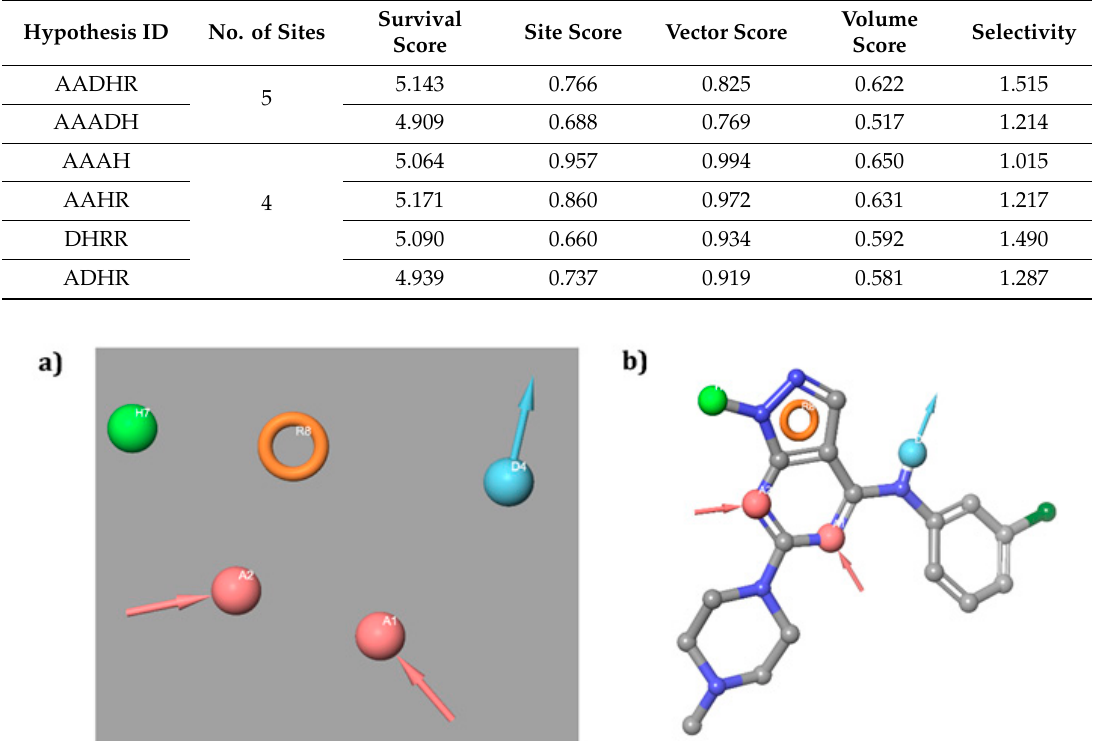
Table 1. Hypothesis generated through PHASE run.